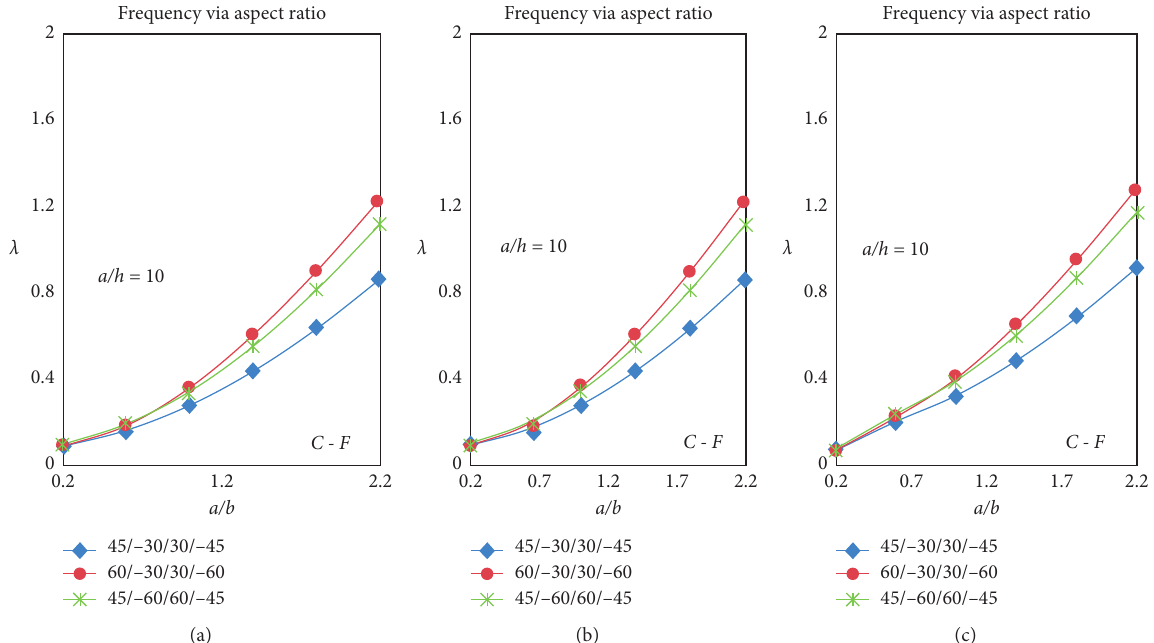
Figure 15: Influence of aspect ratio on frequency parameter value of 4-layered plates under C-F support condition.